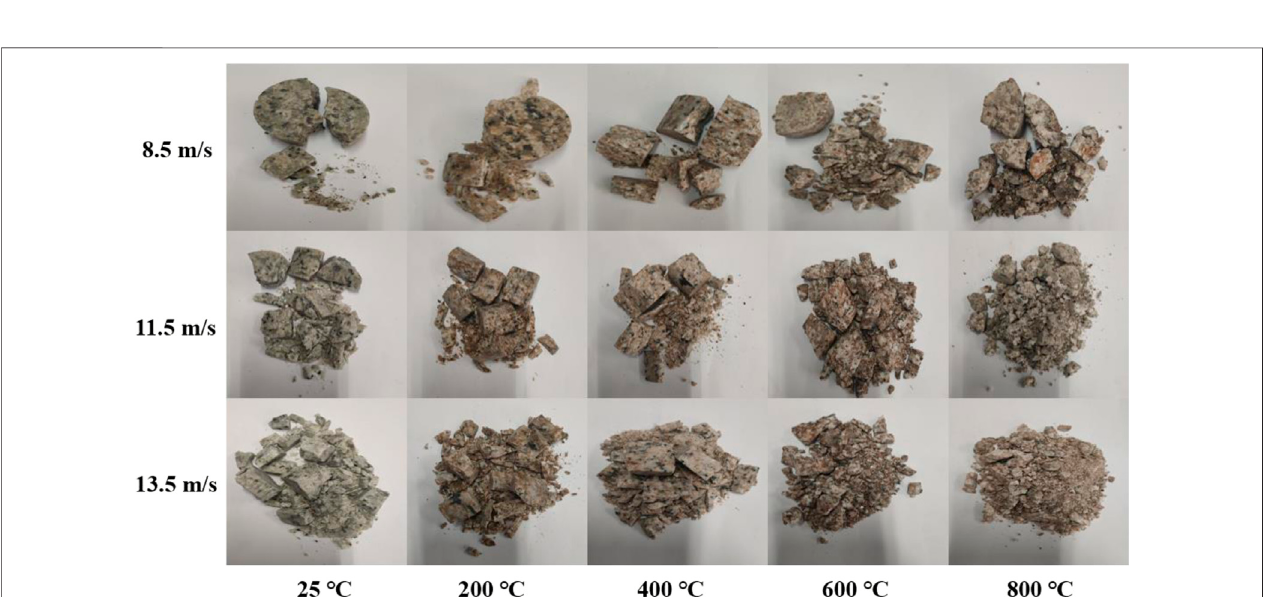
FIGURE 7 | Failure modes of granite under different temperatures and impact velocities.